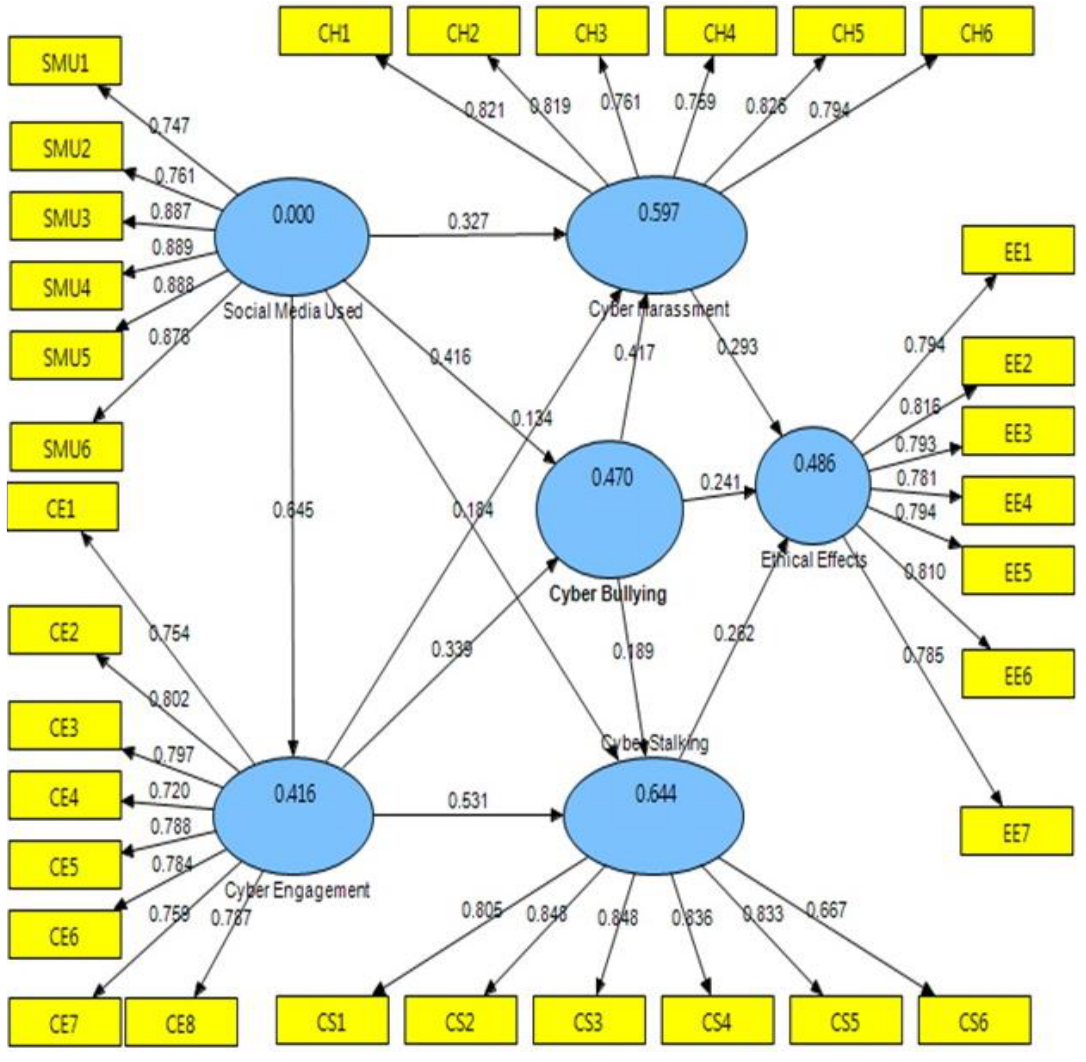
Figure 2. Path coefficients results.